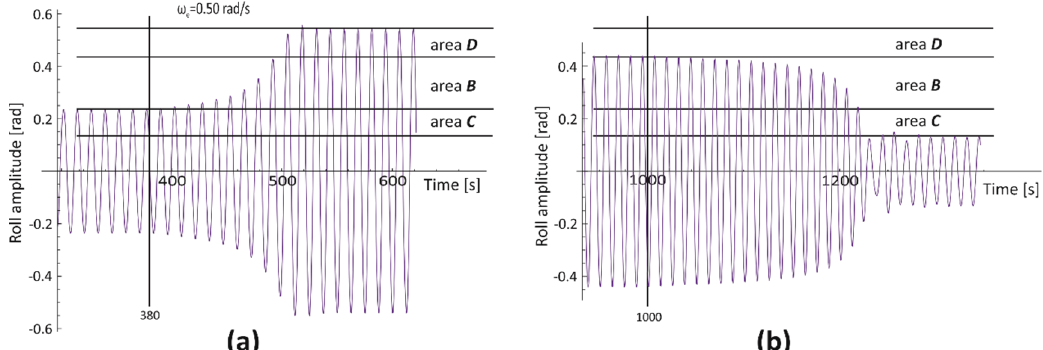
Figure 7. Roll time history for the OSV vessel ( T = 6.10 m, GM 0 = 2.50 m). Transitions between the bistability areas cause by a very small and smooth change in the value of the exciting moment (change by 1% of its initial value); ( a )—jump-up, ( b )—jump- down.